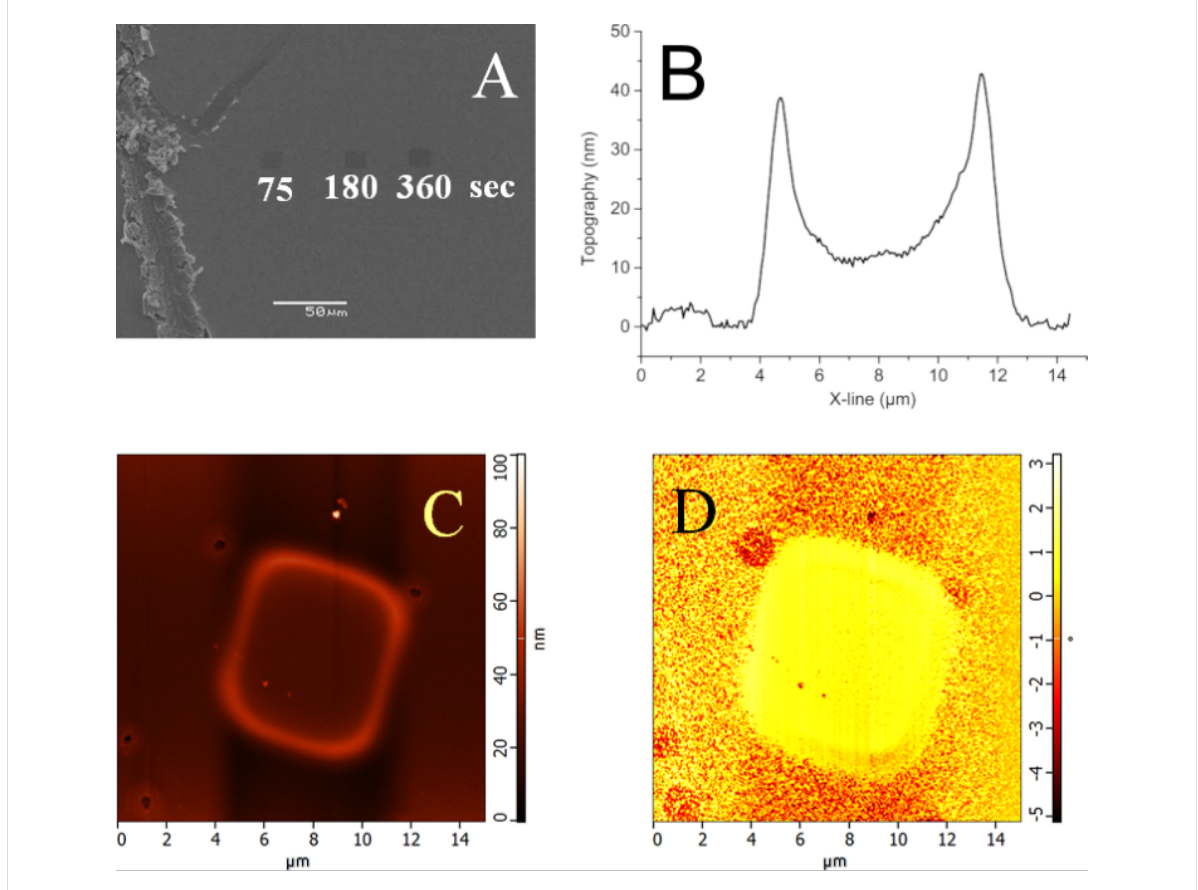
Figure 5: (A) SEM image of the Au layer (33 nm in thickness) on Bi 2 Se 3 irradiated by the electron beam for different periods of time; (B) topograph- ical profile across the irradiated area taken from (C); (C) topographical AFM and (D) and phase-contrast AFM image of the e - beam-irradiated (360 s) Au layer (33 nm in thickness) on Bi 2 Se 3